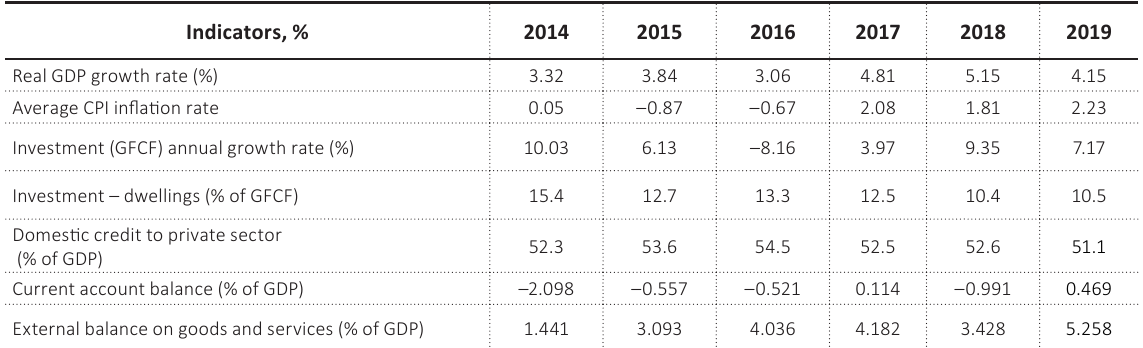
Source: Own study based on World Bank data and OECD data.